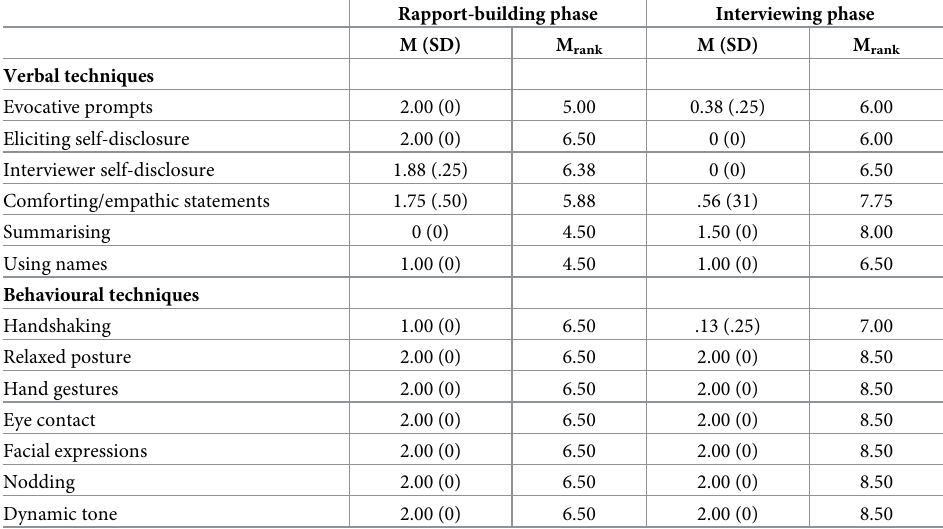
Table 4. Mean coding and Kruskal-Wallis rankings (standard deviations) for the techniques in the full rapport condition as a function of the rapport-building and interviewing phase.